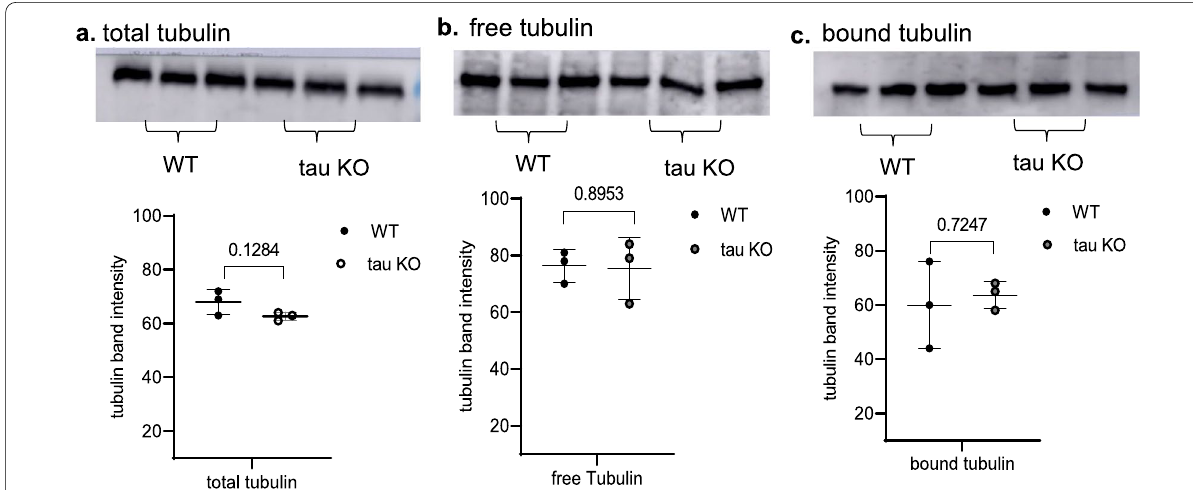
Fig. 4 Tubulin assay using the commercially available, cytoskeleton-based MT kit with western blots of a total, b free, and c bound tubulins and their respective intensities in wild type (WT) and tau knock out (KO) mice ( n bound tubulin